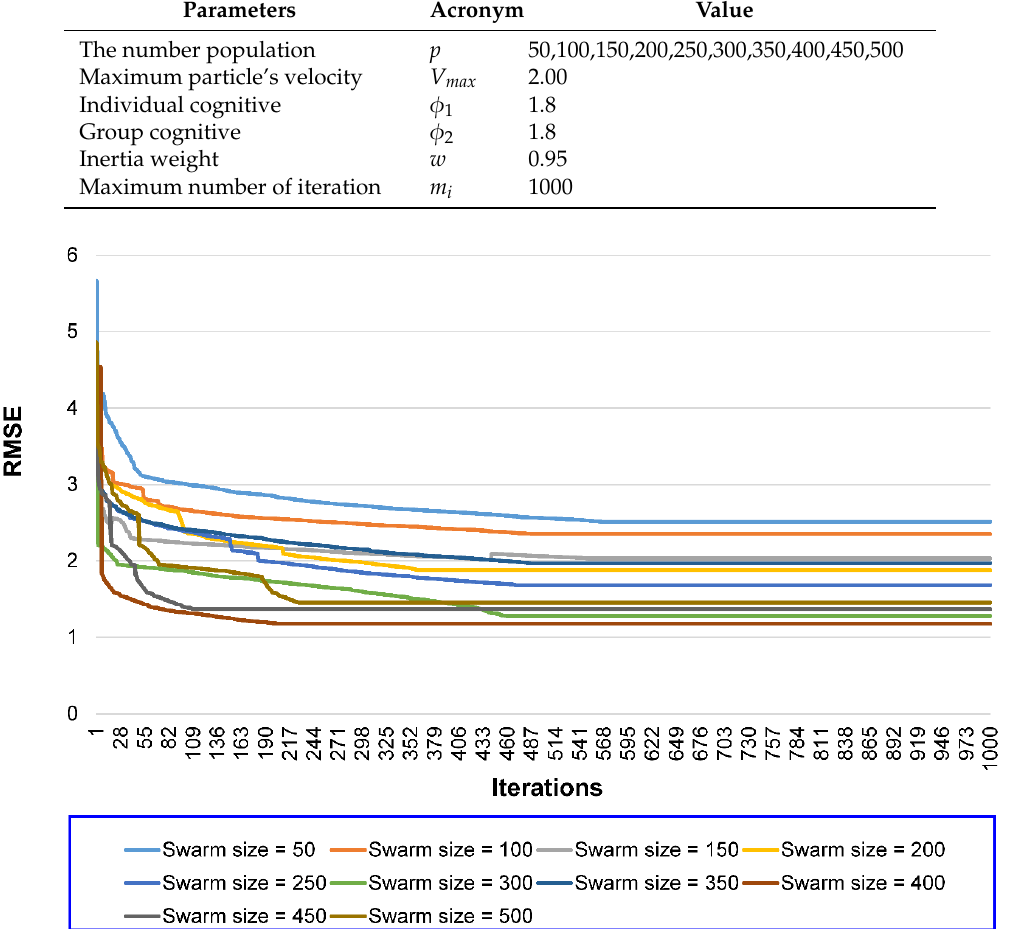
Figure 5. Performance of the proposed PSO-XGBoost technique in estimating the HL of Figure5. building systems.